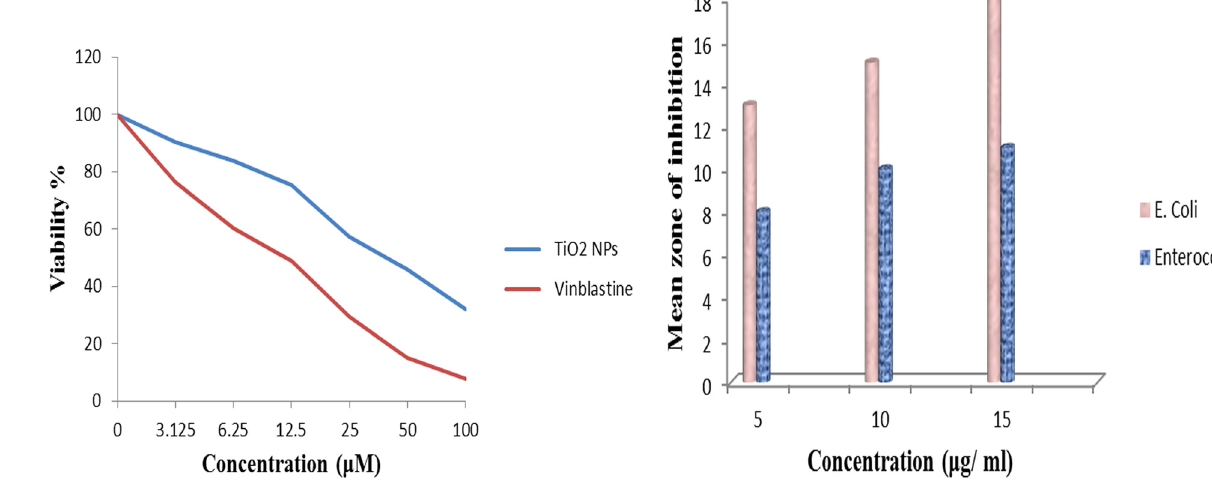
Figure 5: Cytotoxic activity of the green TiO 2 NP suspension compared with that of Vinblastine against MCF - 7 cell line.